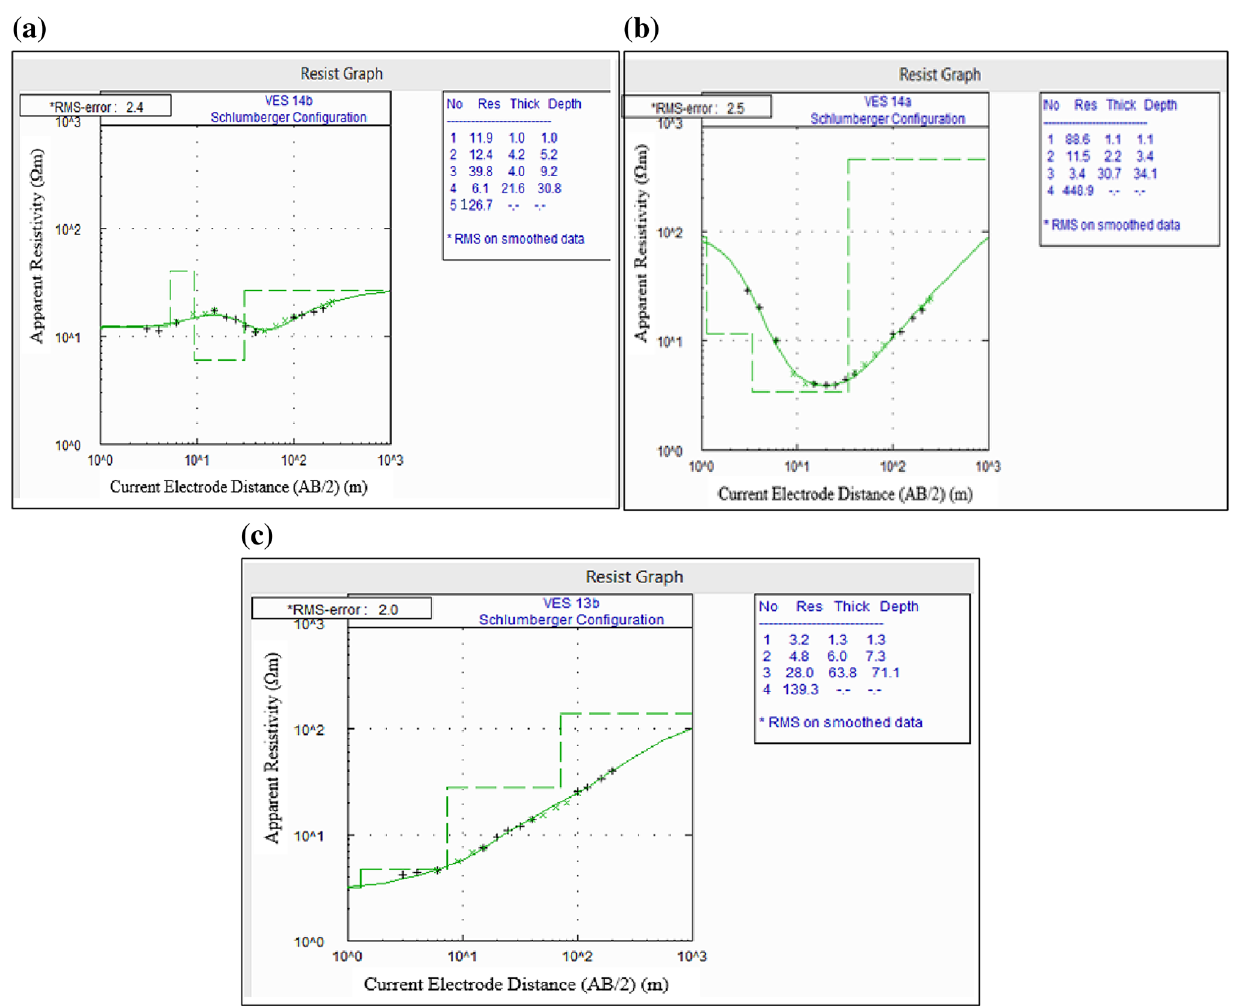
Fig. 3 VES sounding curves obtained along traverse 1 on the dumpsite in a 2001 b 2002 and c 2006